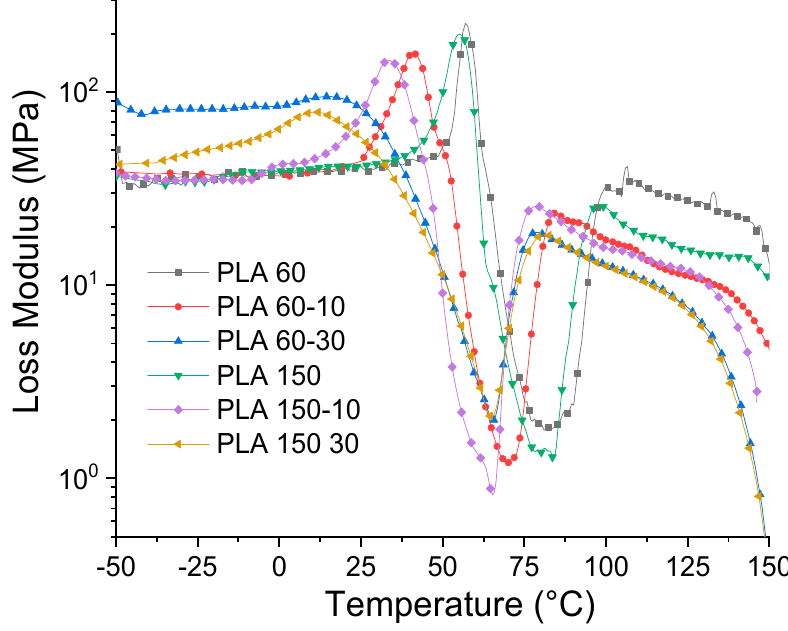
Figure 13. Loss modulus for PLA and PLA /